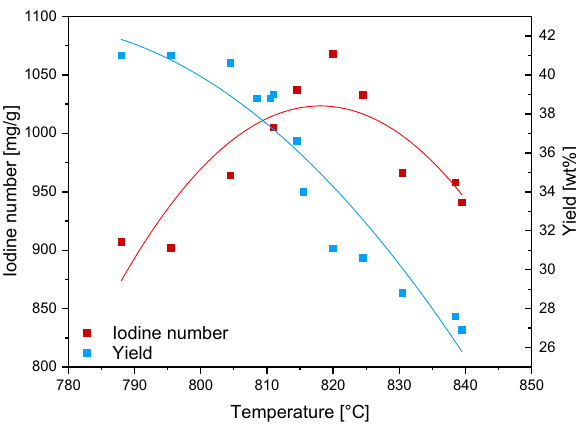
Figure 3. Relation of activation temperature and the yield of activated carbon, and iodine number.